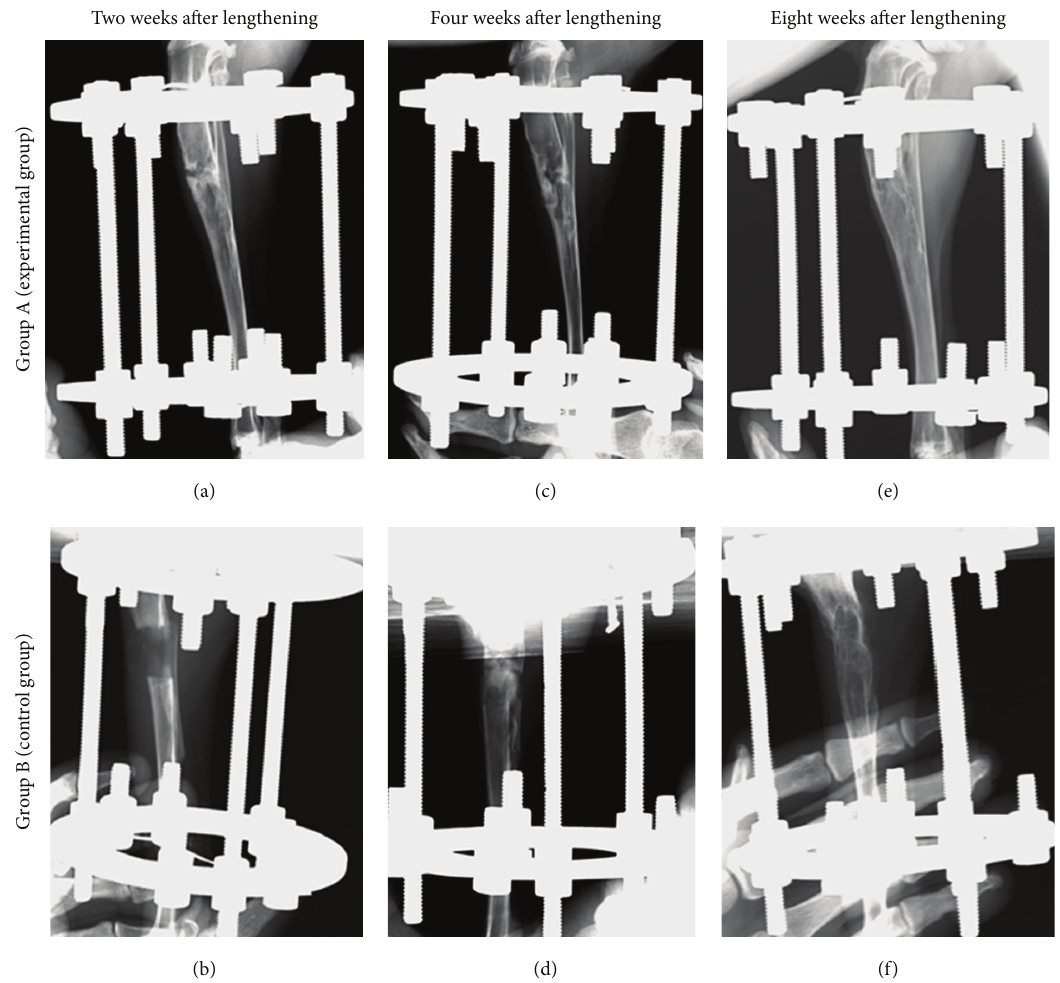
Figure 8: The X-ray image of rabbit tibia in different group at different time after